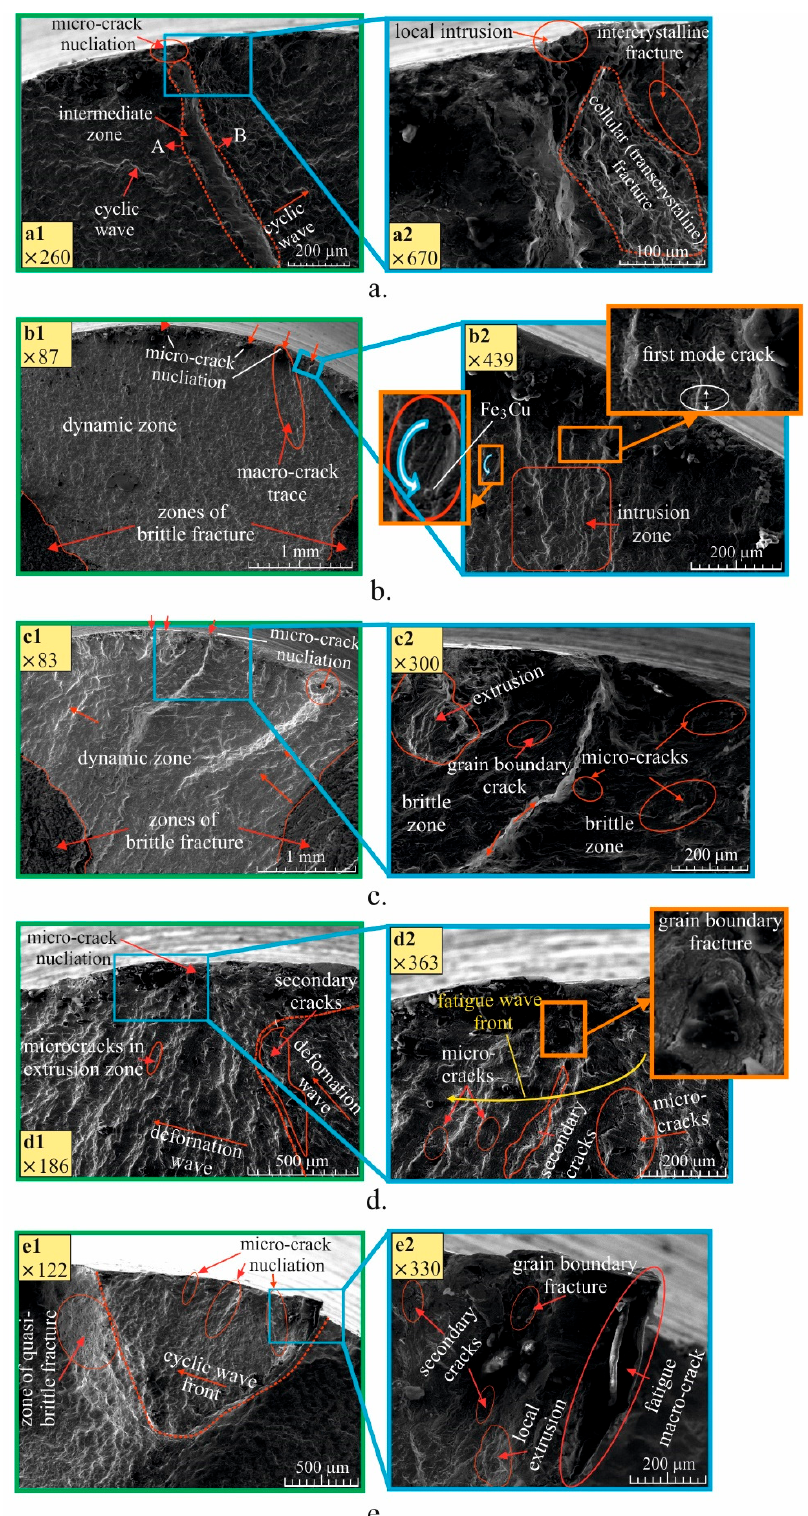
Figure 15. Fracture surfaces of the fatigue specimen heat treated in different manner: ( a ) as received; ( b ) annealed; ( c ) quenched; ( d ) quenched and tempered at C600 o ; ( e ) quenched and tempered at ( b ) annealed; ( c ) quenched; ( d ) quenched and tempered at 600 ◦ C; ( e ) quenched and tempered at C300 o . 300 ◦